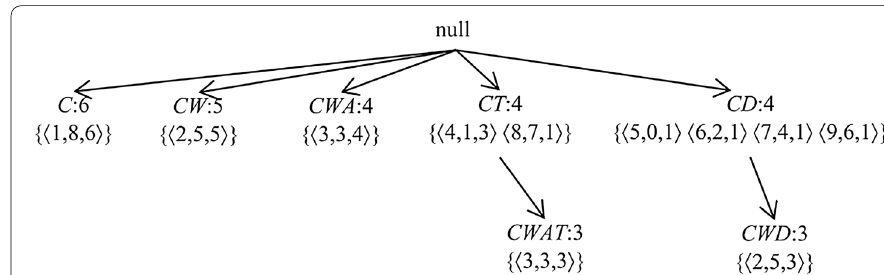
Fig. 6 One-repetition frequency patterns and their N-List [25]